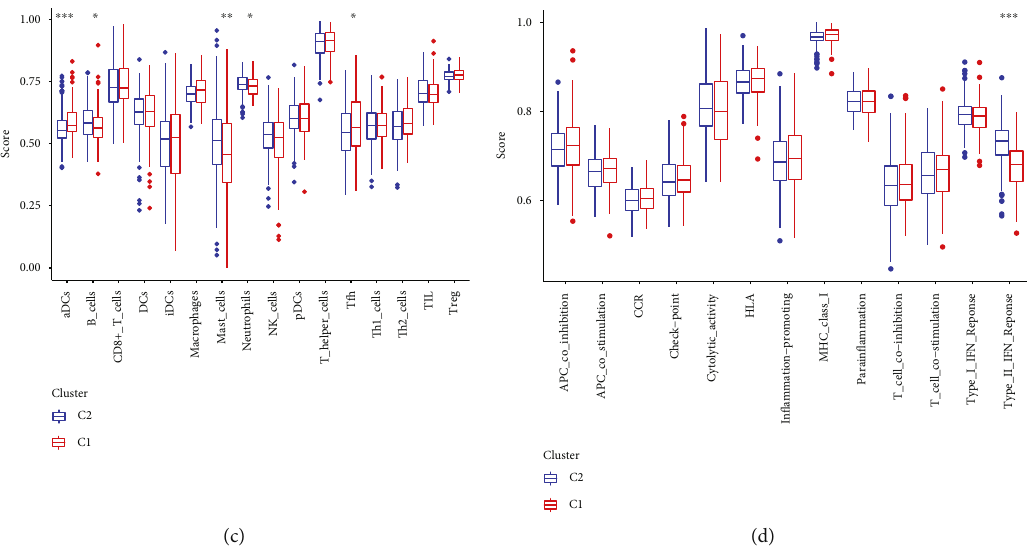
Figure 5: The immune landscape of two cuproptosis-related clusters in HCC. (a) The immune in fi ltration heatmap between the two clusters using TIMER, CIBERSORT, CIBERSORT-ABS, QUANTISEQ, MCPcounter, XCELL, and EPIC algorithms. (b) The gene expression levels of immune checkpoints for the two clusters. (c) The ssGSEA for examining subpopulation associations in immune cells. (d) The ssGSEA for examining subpopulation associations in immune functions. ∗ p < 0 : 05 , ∗∗ p < 0 : 01 , ∗∗∗ p < 0 : 001